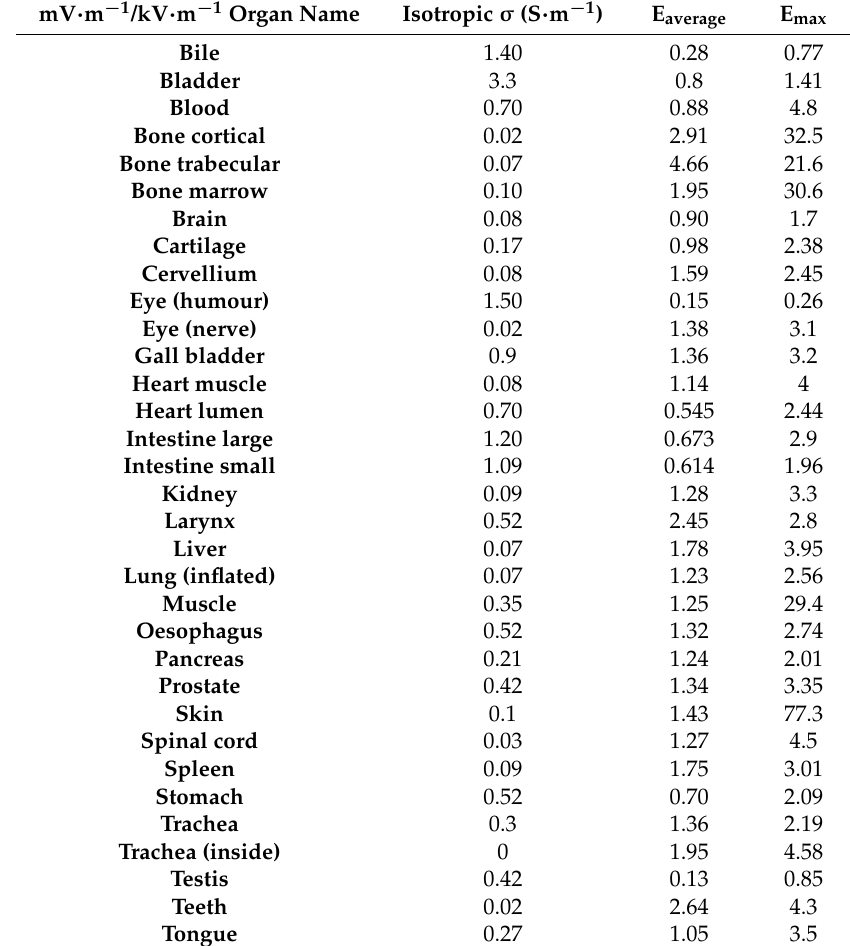
Table 3. Ansoft body model (2 mm resolution) top irradiation and grounded conditions, electric field induced on the organs (mV · m − 1 ) due to 1 kV/m of the 50 Hz uniform electric field exposure